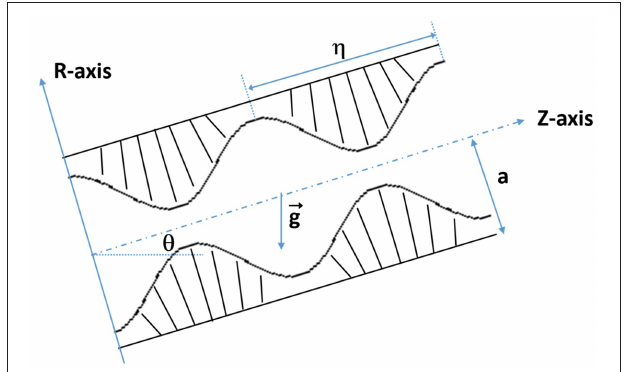
· ̹ is the strain rate,